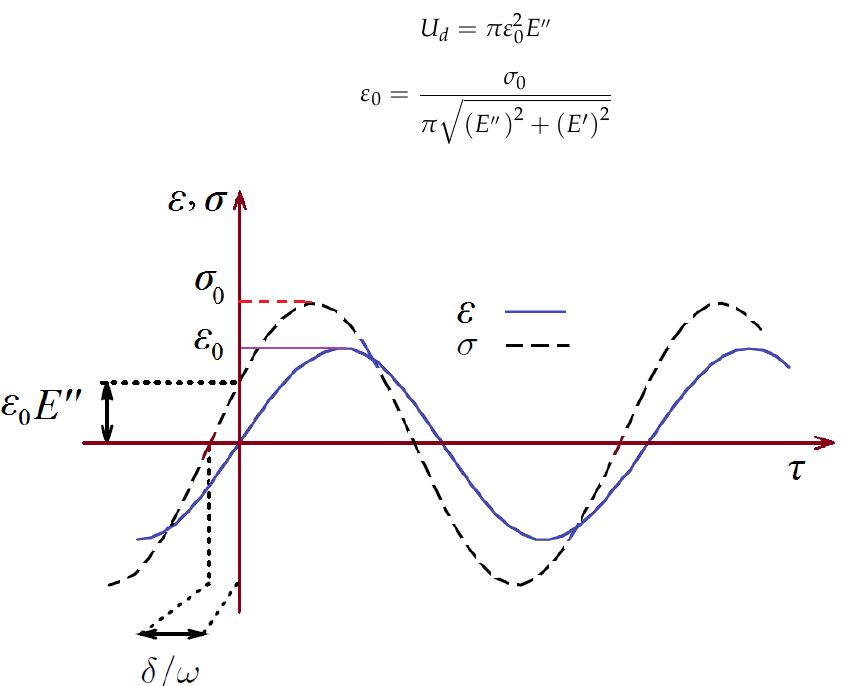
Figure 2. Harmonic strain excitation and stress response. E (cid:48)(cid:48) and E (cid:48) are loss modulus and storage modulus, respectively. In addition, ε 0 and σ 0 and are strain and stress amplitudes,